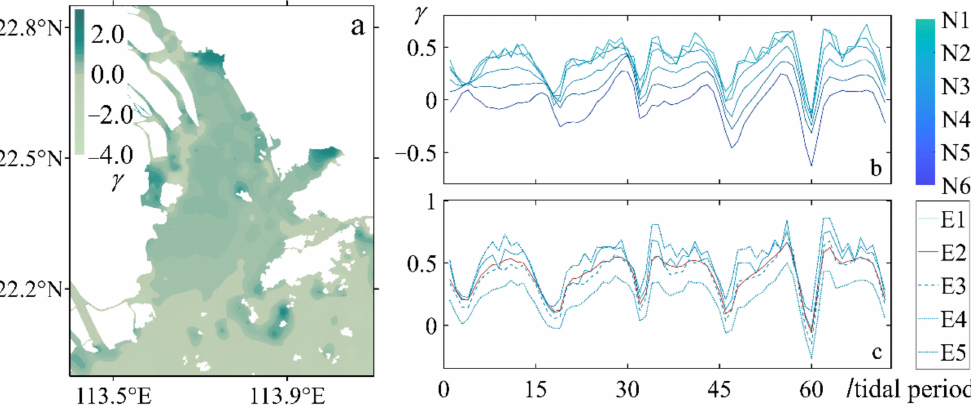
Figure 7. Spatio-temporal variations of FDA in the LDB: ( a ) spatial variation of FDA; the color bar indicates the value of skewness; ( b , c ) time series of FDA of the selected stations (Figure 1d,e); the legend and the color bar correspond to the selected